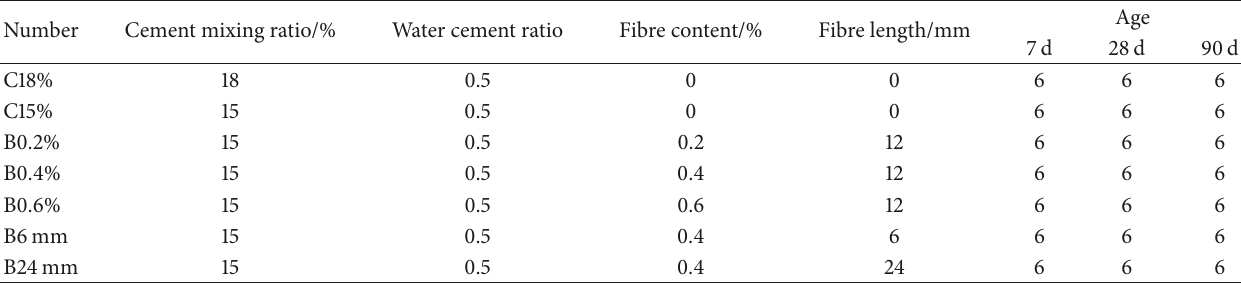
Table 4: The ratio of test